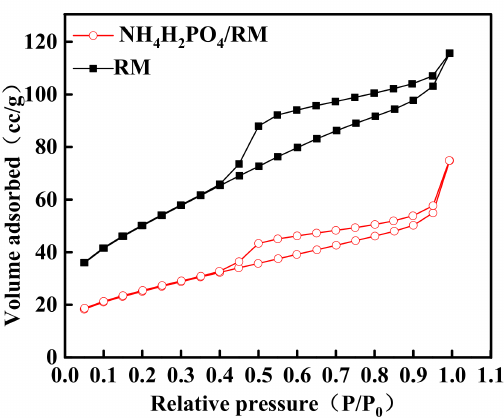
Figure 4. N 2 adsorption-desorption isotherms of NH 4 H 2 PO 4 /RM composite powders and